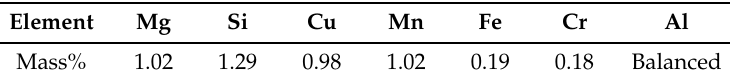
Table 1. Composition of 6066 aluminum alloy.